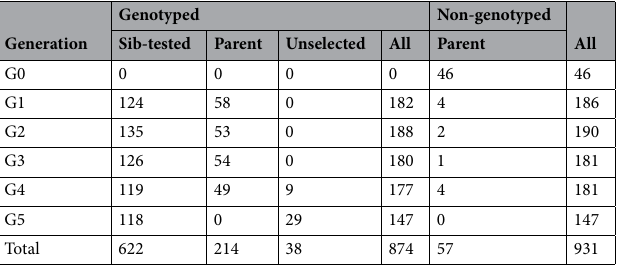
Table 1. The number of genotyped and non-genotyped animals by generation in